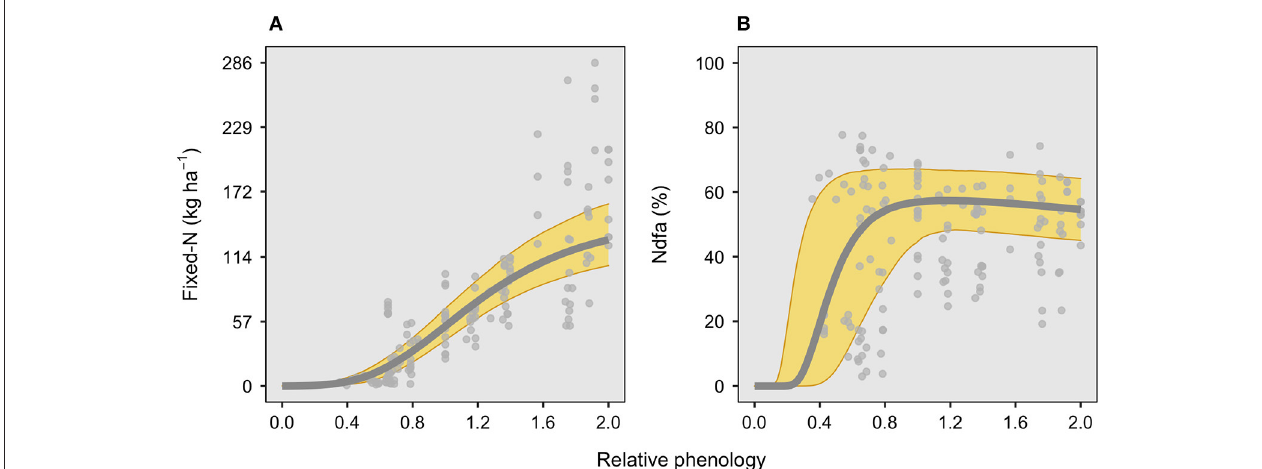
FIGURE 1 | Seasonal evolution in fixed-N (kg ha − 1 ) and N derived from the atmosphere, Ndfa (%), over a relative phenological scale for soybean crop ( Table 1 ). Relative phenology scale, 0 Emergence, 1 pod formation (R3 stage), and 2 physiological maturity (R7 stage). For (A) , the root mean square error (RMSE) for fixed-N was 39kg ha − 1 , while for (B) , the RMSE for Ndfa was 21%, with both panels comprising 15 studies with 148 observations